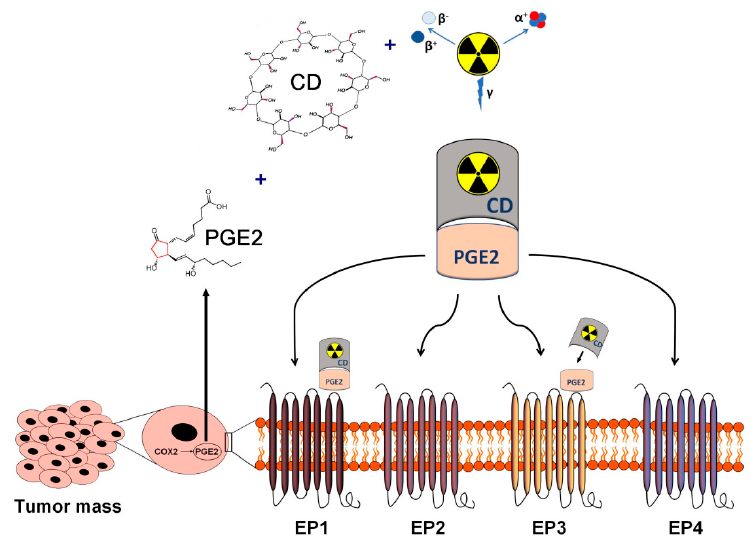
Figure 1. Schematic overview of the in vivo diagnostics and radioisotope therapy of PGE2-expressing and PGE receptor-positive tumors using radiolabelled CDs. Applying radioisotopes with diagnostic ( γ ) and therapeutic radiation ( α or β ), radiolabelled CDs complexed with tumor cell derived PGE2 may establish the basis of target-specific diagnostics and personalized radionuclide therapy of PGE2-expressing malignancies. CD: cyclodextrin; PGE2: prostaglandin E2.